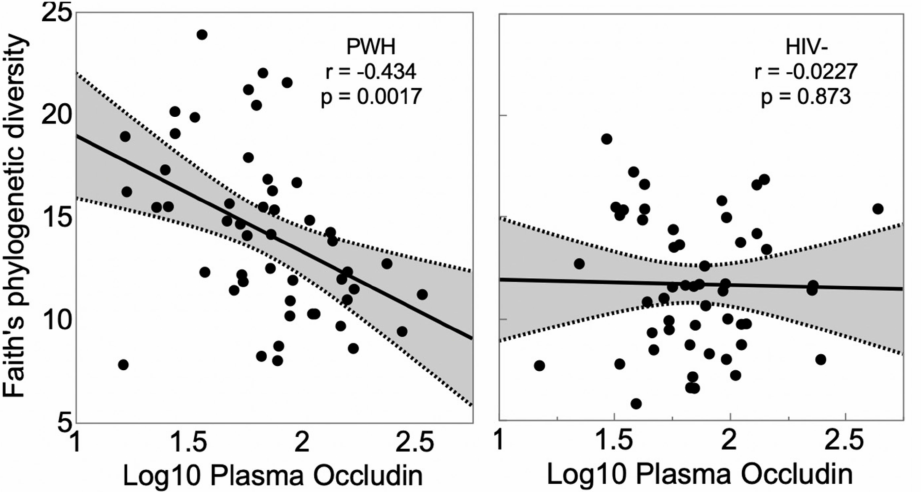
Figure 1. Lower gut microbiome diversity as indexed by Faith’s PD was associated with higher plasma occludin levels in PWH but not in HIV uninfected (PWoH). The correlation between Faith’s PD and plasma occludin in PWH was driven by men who have sex with men (MSM). Thus, in a multivariable model with Faith’s PD and MSM as predictors of plasma occludin, the interaction between Faith’s PD and MSM was significant ( p = 0.0012); among MSM (N = 26), the correlation was r = − 0.3834 ( p = 0.0046), while for non-MSM (N = 13) it was -0.0251 ( p = 0.864). Only 3 participants were self-described as bisexual.